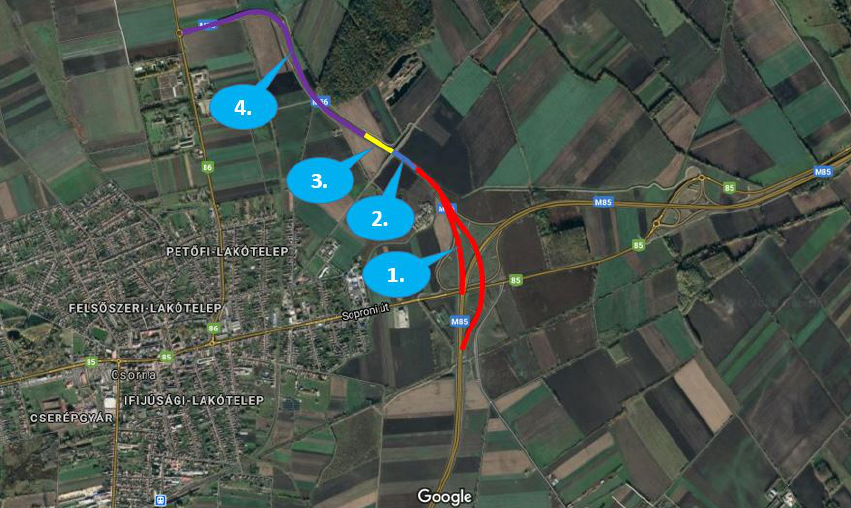
Figure 6. Road sections of the test site (3.5 km in all) located near Csorna City (Hungary) on Route E65 (GNSS coordinates: 47.625778,